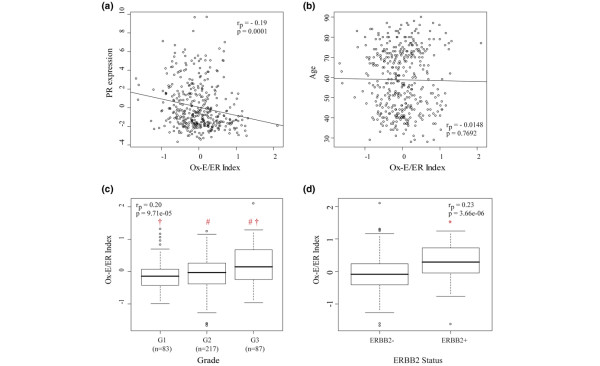
Correlation between Ox-E/ER expression index and clinical parameters in a set of 394 ER-positive breast tumors. (a) Scatter-plot of progesterone receptor (PR) expression levels versus Ox-E/ER index values. Line denotes the linear regression fit of the Ox-E/ER index to PR gene expression. (b) Scatter-plot of age versus Ox-E/ER index. Line denotes the linear regression fit of the index to age. (c) Box plot of the Ox-E/ER index versus tumor grade. Significant differences in Ox-E/ER index with respect to grade are denoted with symbols (# and †; t-test, P < 0.05). Pearson correlations between the index and grade are also shown. (d) Box plot of the Ox-E/ER index versus ERBB2 tumor status, determined as described in Materials and methods. Pearson correlations between the index and ERBB2 status are also shown. *Statistically significant differences in Ox-E/ER index with ERBB2 status (t-test, P < 0.05). ER, estrogen receptor; Ox-E/ER, oxidant-sensitive estrogen/ER gene signature.